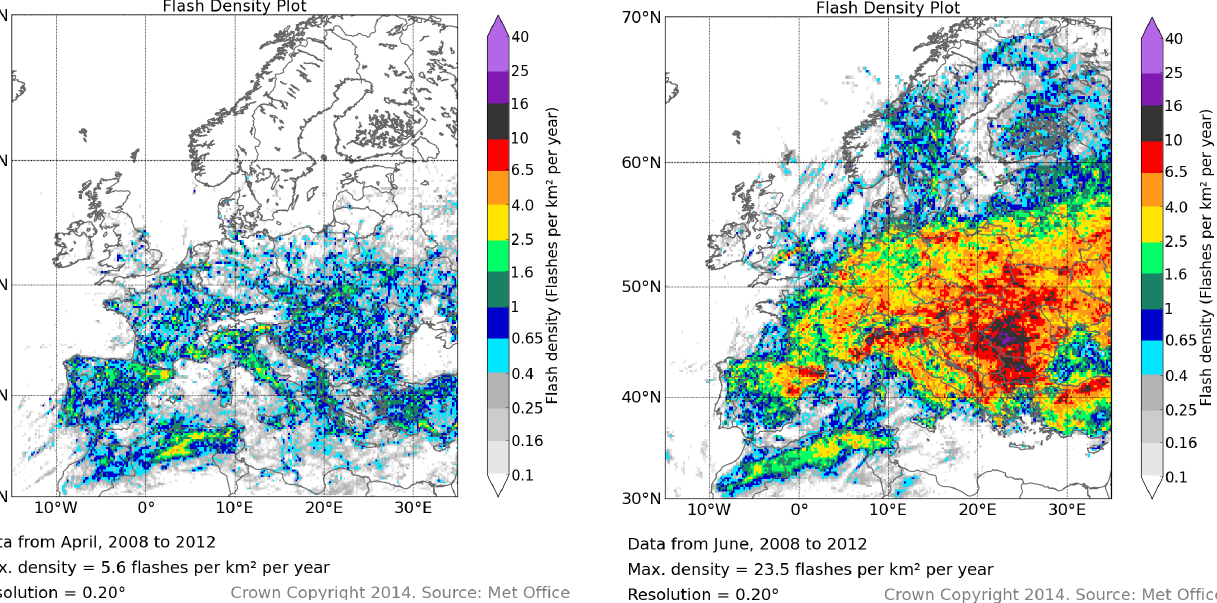
Fig. 10. Detected lightning flash density for